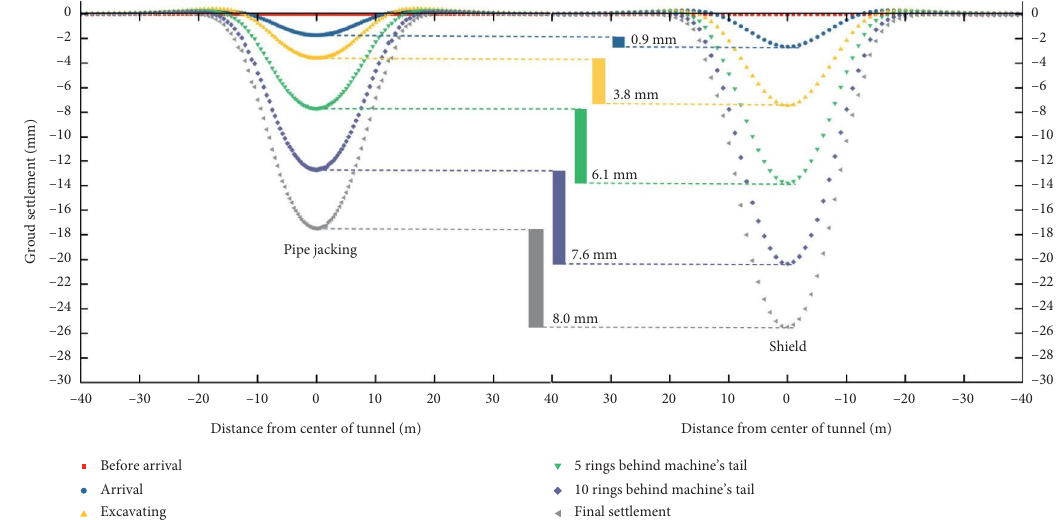
Figure 10: Transverse ground surface settlement of pipe jacking and shield in each stage.